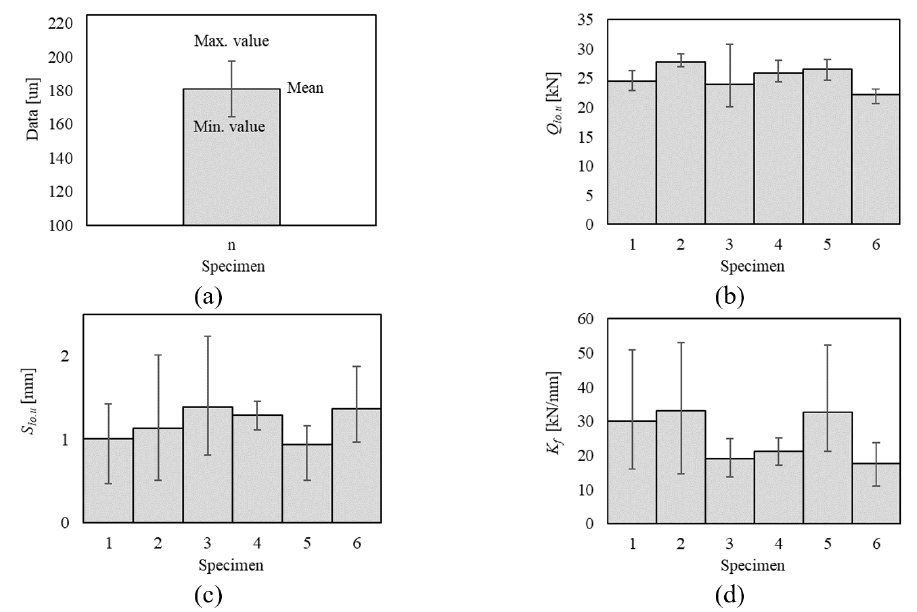
Figure 17. Bar chart of push-out test results: (a) graphics legend; (b) ultimate load; (c) relative displacement; (d)